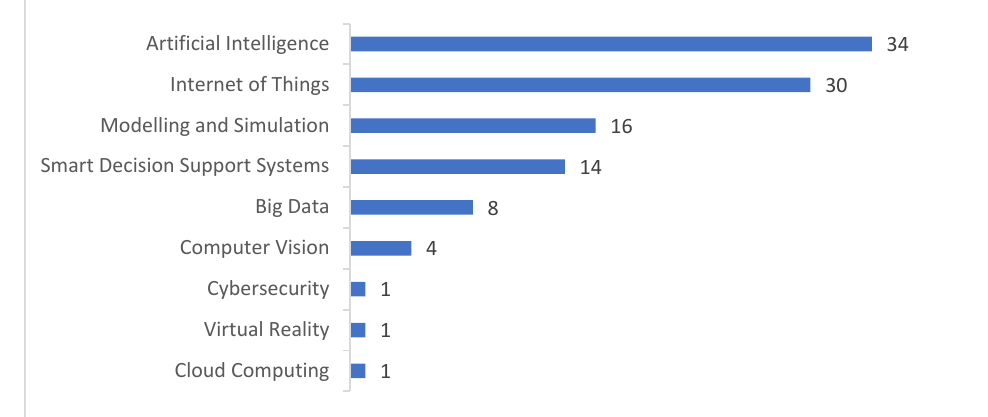
Figure 11. Number of articles per industry 4.0 technology.